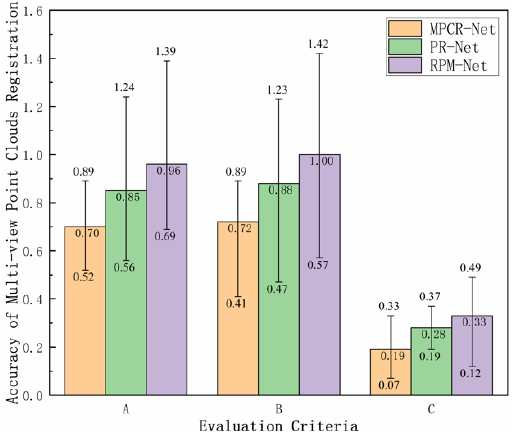
Figure 20. Registration accuracy of MPCR-Net, PRNet, and RPM-Net on hulls a–i.